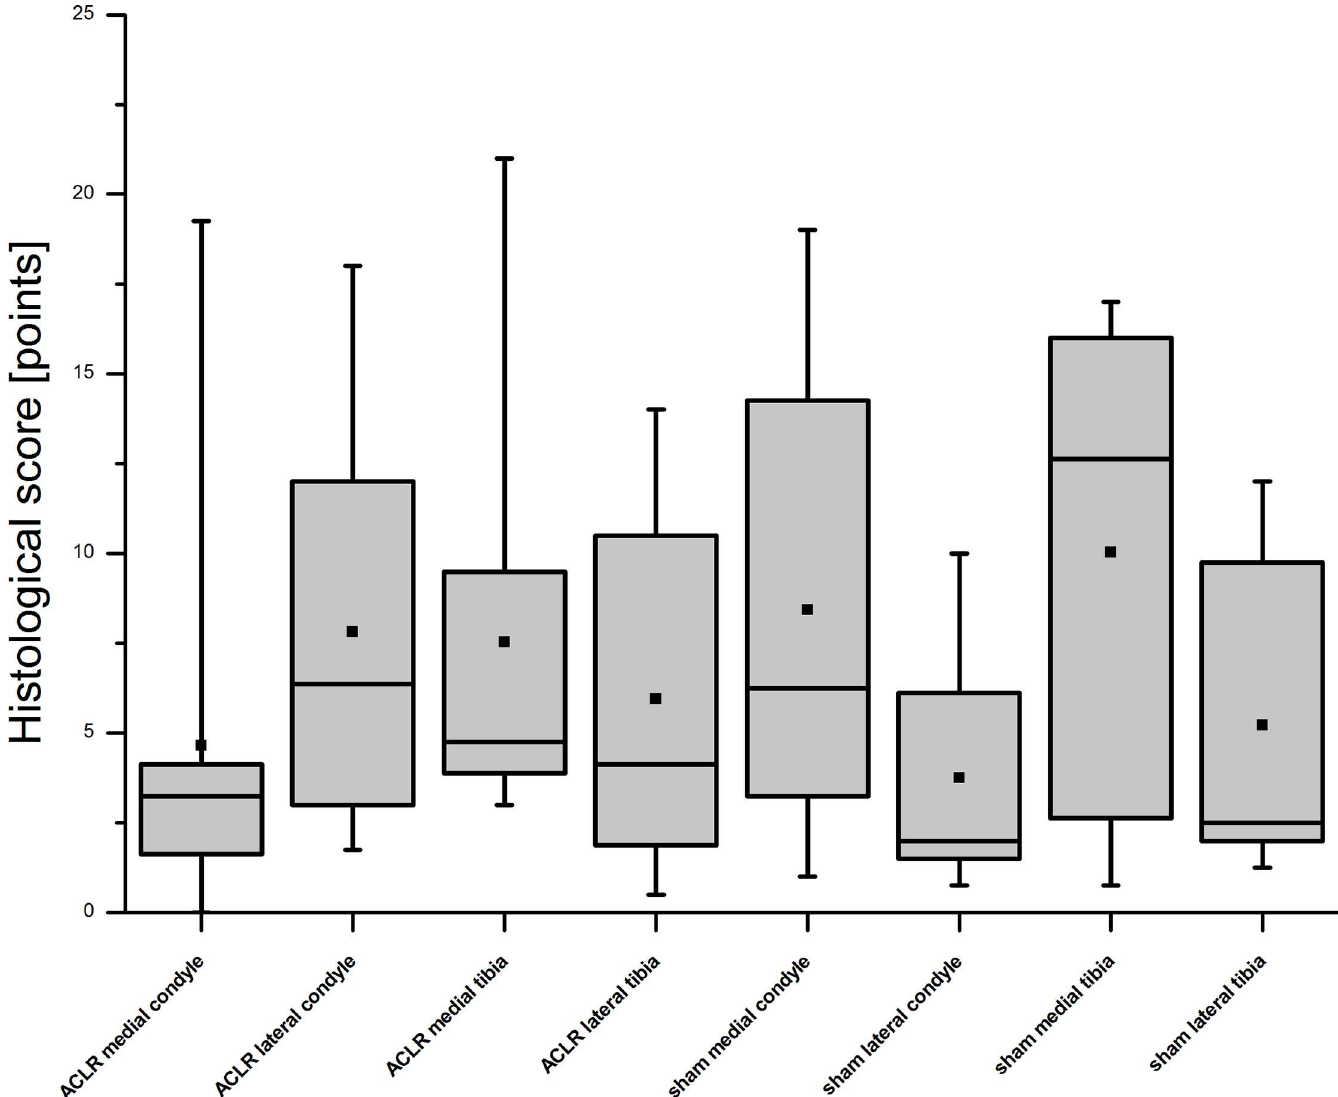
Fig 2. Results of the histological scoring after consensus. The score for each area of interest–the medial/lateral condyle and the medial/lateral tibiaplateau of the ACLR and sham-operated knee joints- of eight Go ¨ ttingen Minipigs are shown. The used score [35] ranges from 0 points with no changes up to 25 points. As the results of the scoring showed, the sham knee joints were also affected with no significant differences between the ACLR and sham operatedknee